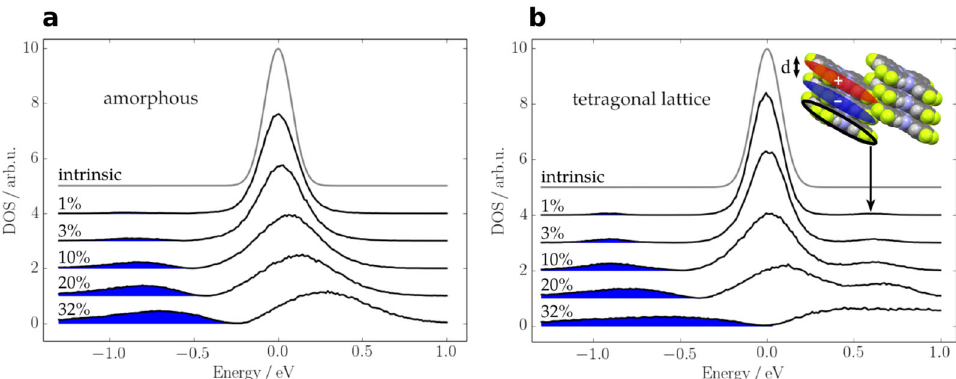
Fig. 1 Exemplary density of states for different doping concentrations. a Amorphous material, i.e. with point-molecules placed randomly, but with a minimal distance of 0.5 nm. b Tetragonal lattice using the lattice spacings of ZnPc (see Supplementary Table 1 for details). The occupied states are shown in blue. With increasing doping concentration, the DOS broadens for both structures, as some states get raised and some get lowered by the one or the other type of charge. In the light doping regime, the peak position of the unoccupied DOS stays constant, due to the equal amount of positive and negative charges. Note that for the tetragonal lattice, an additional peak in the unoccupied DOS arises due to the the neutral ZnPc in the Coulomb potential of the, for n -doping, negatively charged ZnPc next to it and the positively charged dopant two places away (we do not account for a different shape of the dopant molecule). The doping concentrations are given in molar percentages and the plots are offset vertically for clarity.